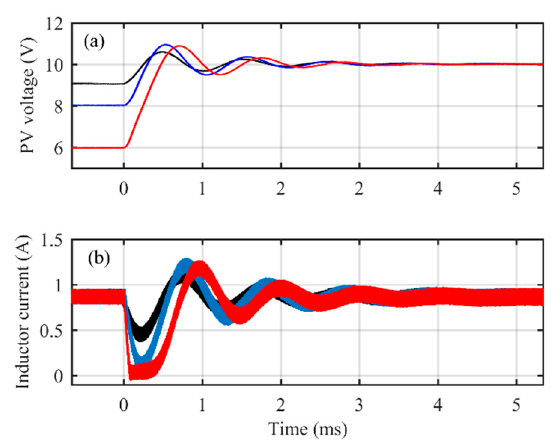
Figure 10. The behavior PVG voltage ( a ) and inductor current ( b ) when step-changes of 0.037 (black), 0.075 (blue), and 0.15 (red) are applied to the duty ratio in CCR.